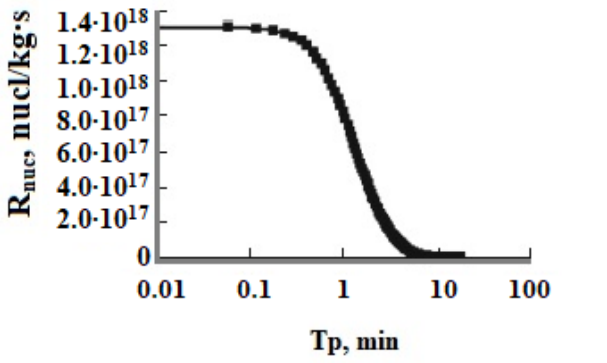
Figure 5. The rate of nucleation R nuc (nucl/(kg · s)) versus time T p ; T = 50 ◦ C, the initial concentration is C s = 700 mg/kg, pH = 8. Table 7. Durations of homogeneous t hom and heterogeneous t hetg nucleation at different temperatures, pH, C s .